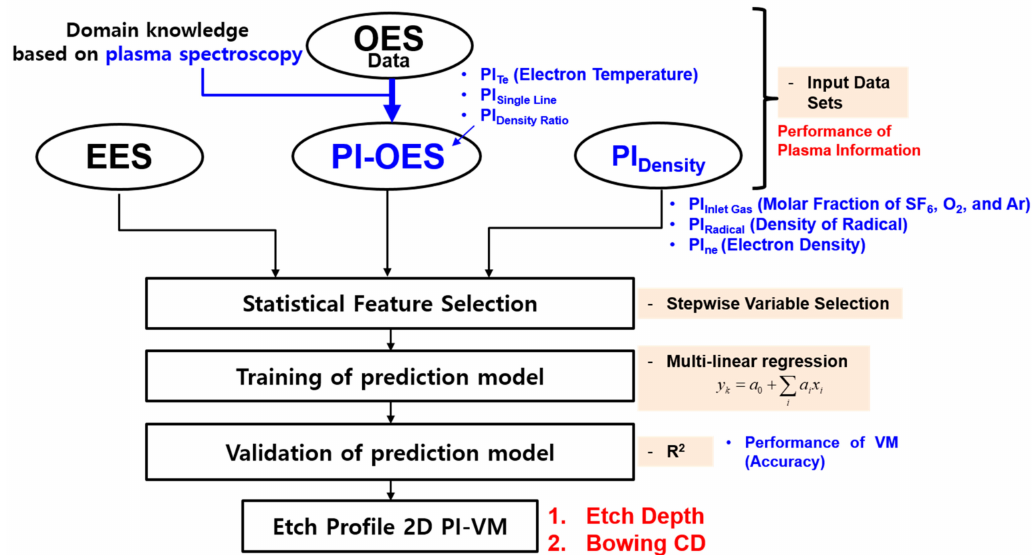
Figure 2. Flow chart of etch profile PI-VM model development.